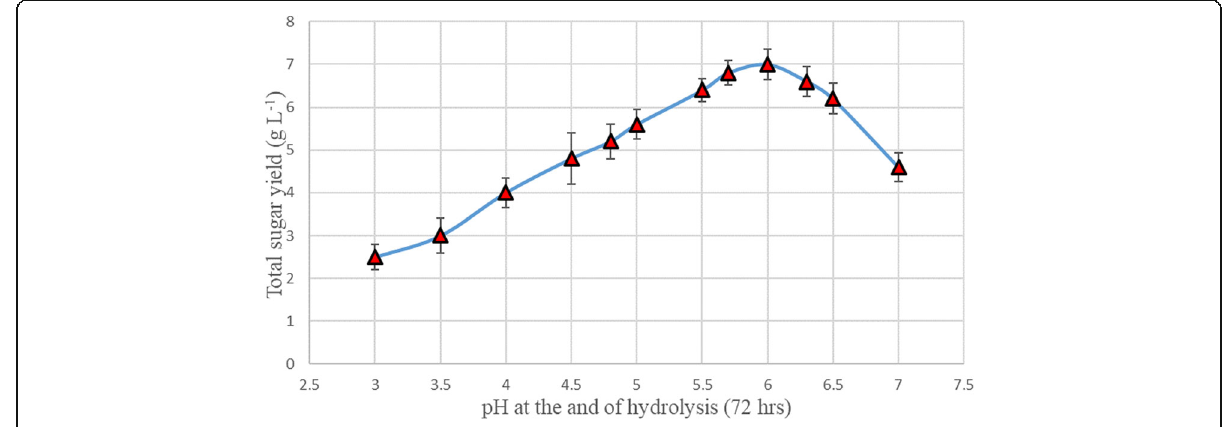
Fig. 2 Total reduced sugar concentration for different pH solution at the end of the hydrolysis (72 h)